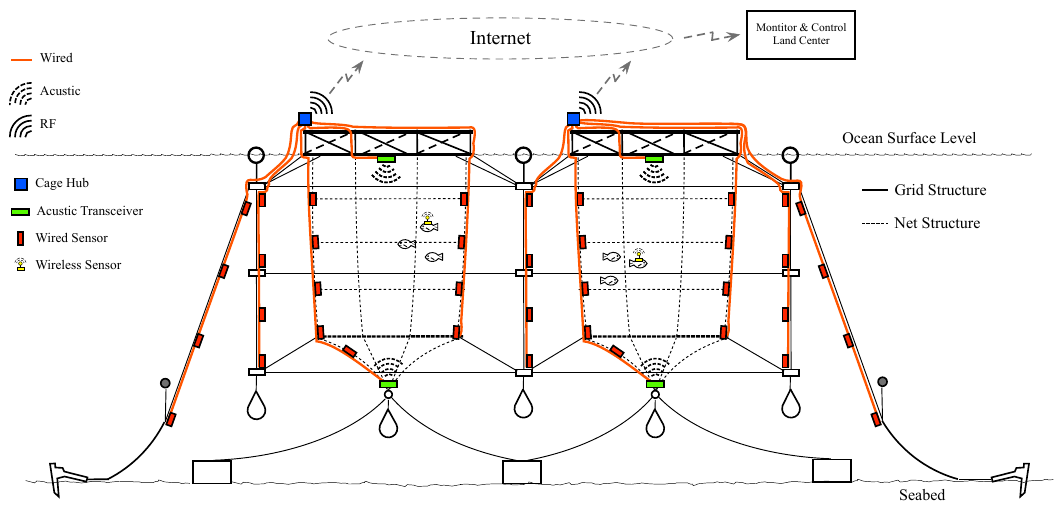
Figure 3a. Each wireless area i is connected to the next wireless area i + 1 by a cable. In general, each defined wireless area contains at least a transmission antenna and a sensor node. If there exists a wireless area i + 1, the wireless area i includes a receiving